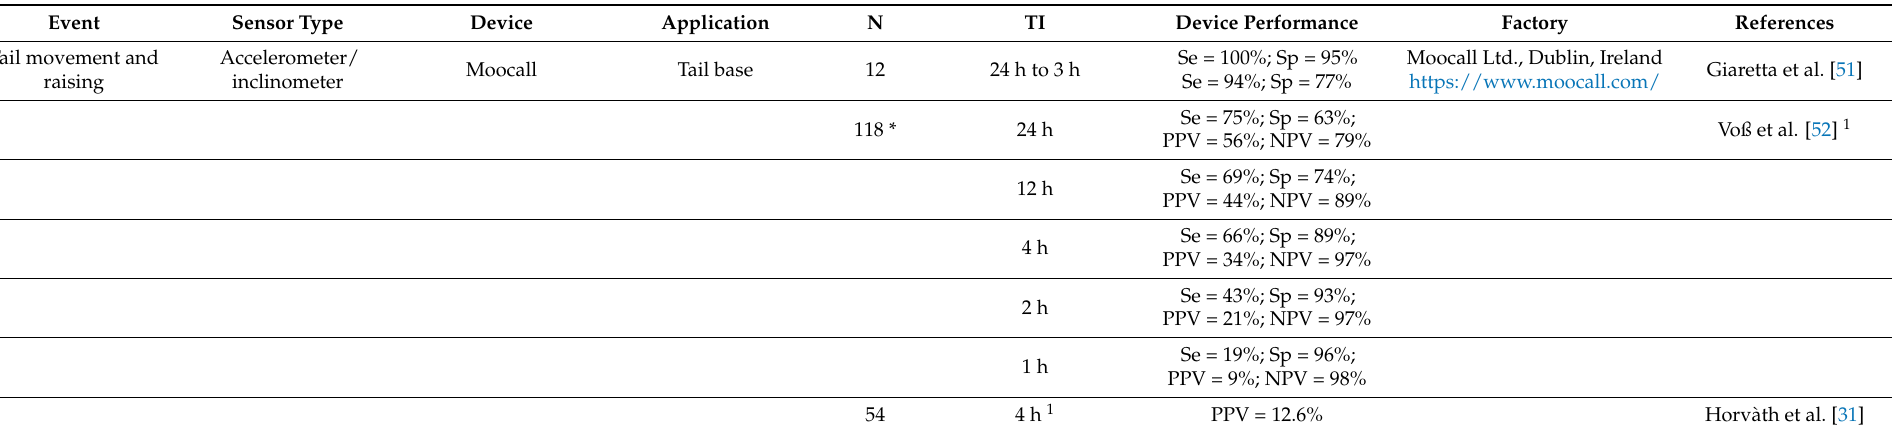
Table 4. Tail movement sensor for calving prediction, with performance and